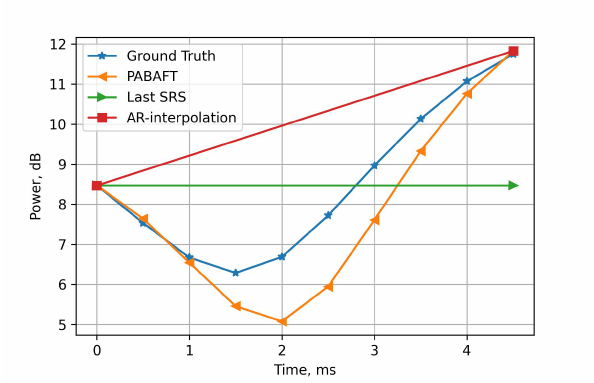
Figure 2. Comparison between different forecasting